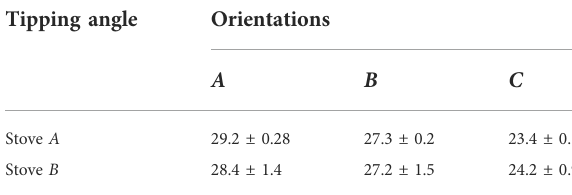
TABLE 7 Ranking of the mechanical stability of Chinese stoves from different orientations based on IWA safety protocol